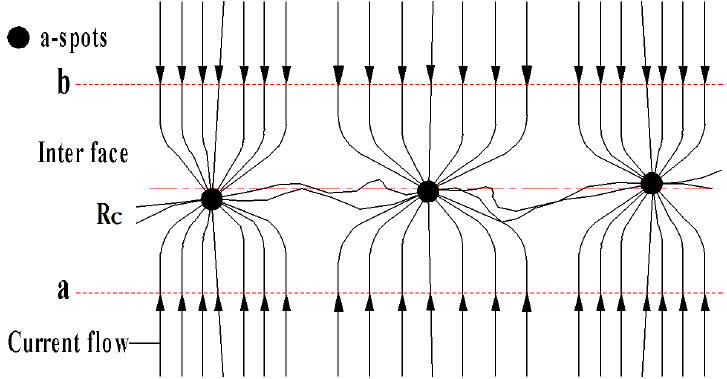
Figure 18. Schematic representation of constriction resistance.